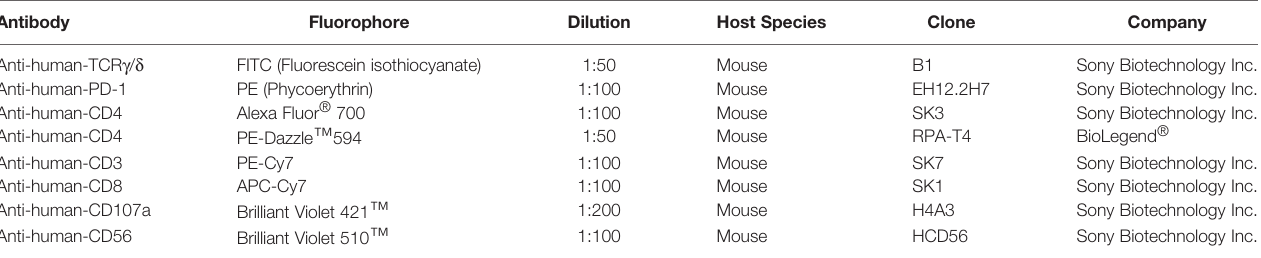
TABLE 1 | Used antibodies with conjugated fl uorophore, used dilution, host species, clone, and the providing company. Antibody